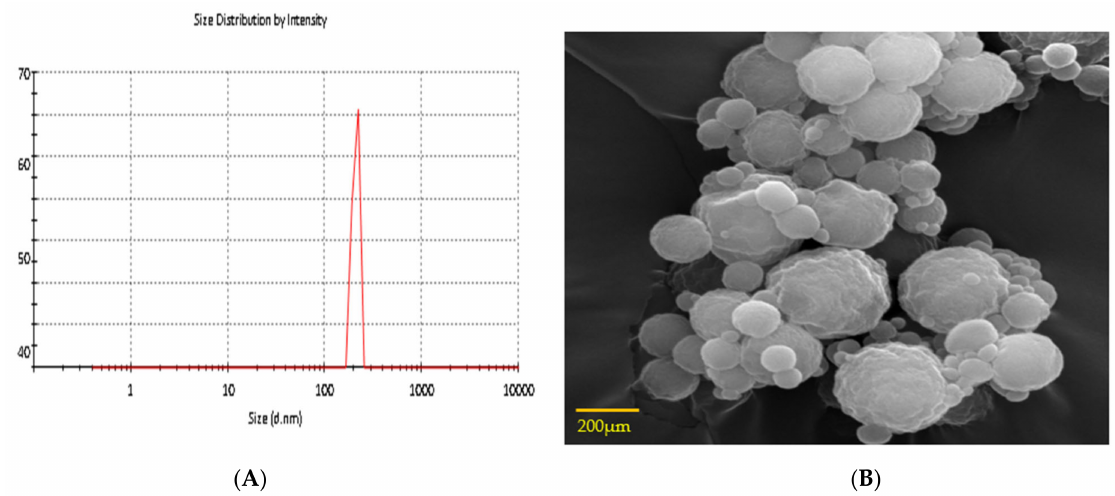
Figure 4. ( A ) Size distribution of nanoparticles, ( B ) surface morphology of folic-acid-modified 5-FU-loaded chitosan